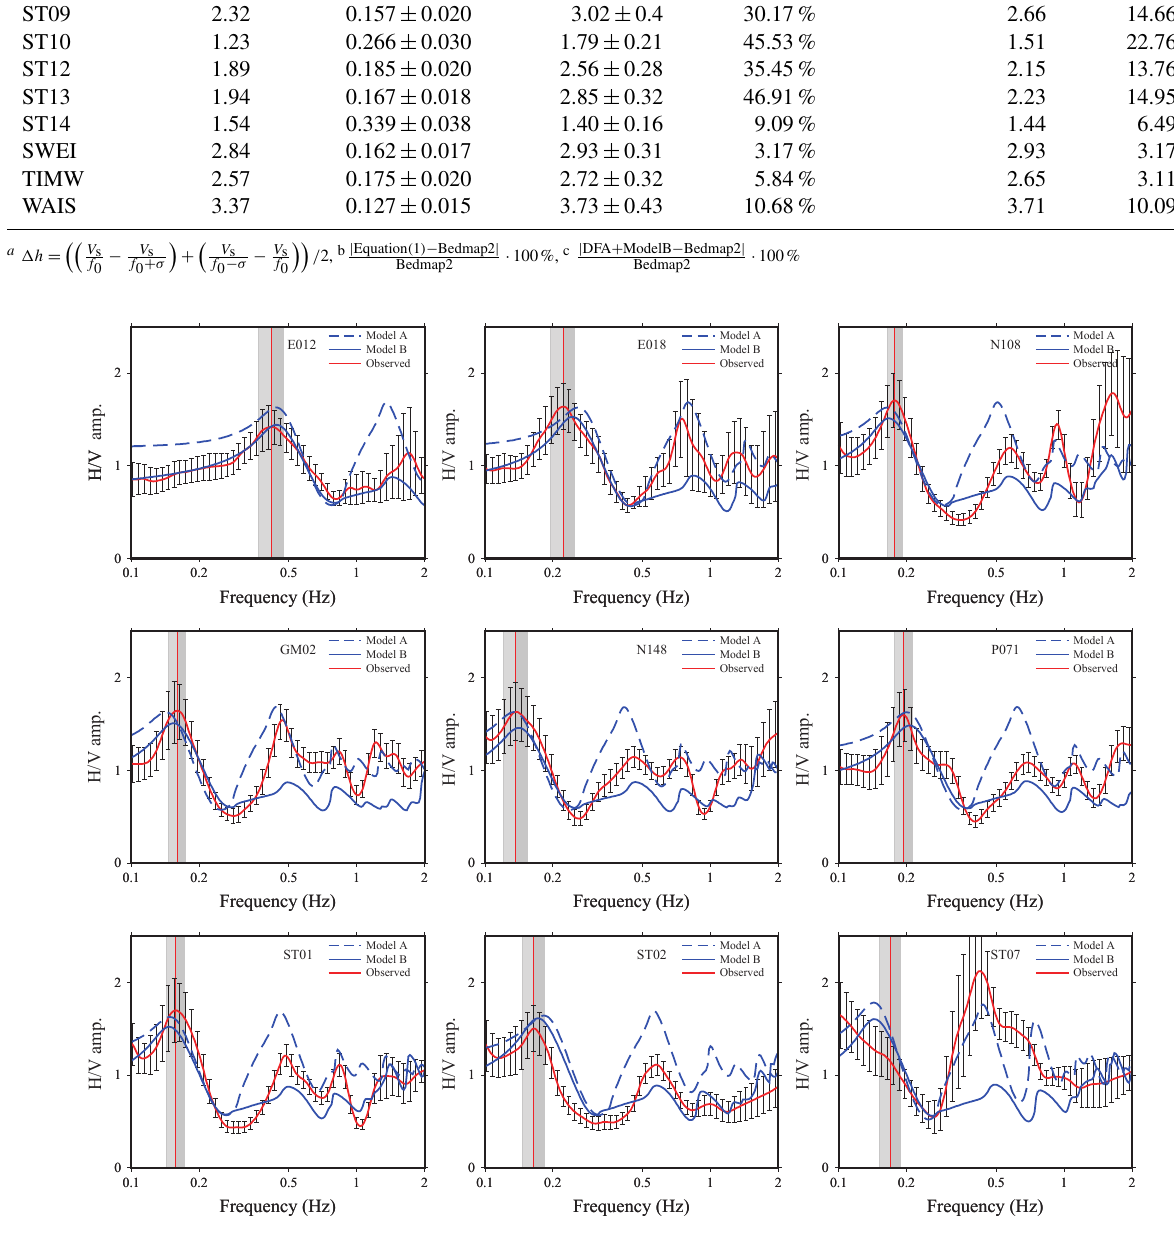
Figure 6. The synthetic H / V spectra and the observed H / V spectrum for the nine stations. The synthetic H / V spectra are modeled using the optimum inversion shear-wave velocity profiles for model A and model B. In all plots except for the last one, the vertical bars are the same as those in Fig. 3 (i.e., the real peak frequency and the associated standard deviation). As for the last one, the peak frequency is approximately calculated using Eq. (1) with its Bedmap2 ice thickness, and the deviation is also approximated with a relative error of 10% to its peak frequency. The two synthetic H / V spectra are both in good agreement with the observed H / V spectrum. Note that the amplitudes of the synthetic H / V spectra are normalized by dividing the whole frequency band by